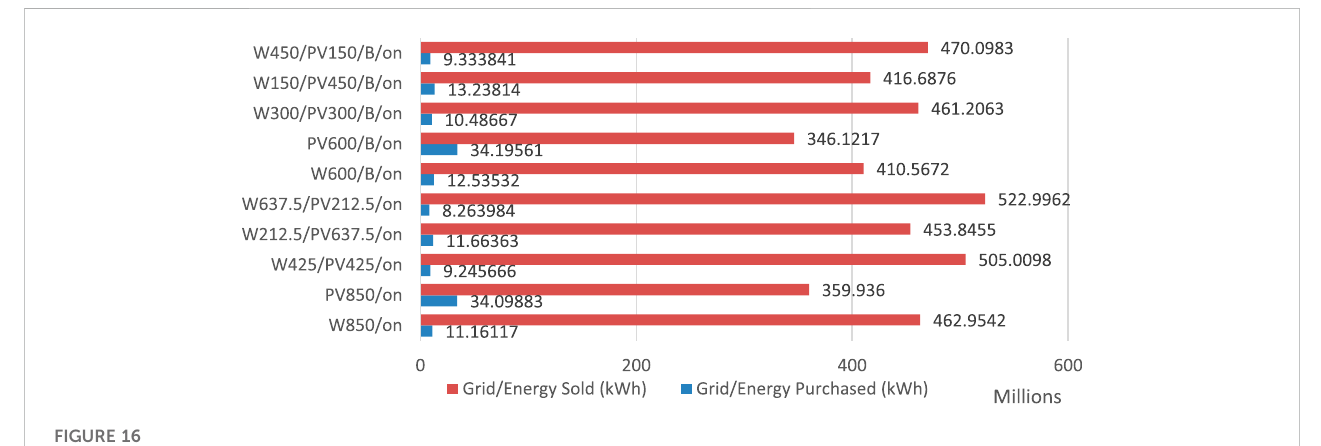
FIGURE 16 Energy sold and purchased from the grid to all grid-connected